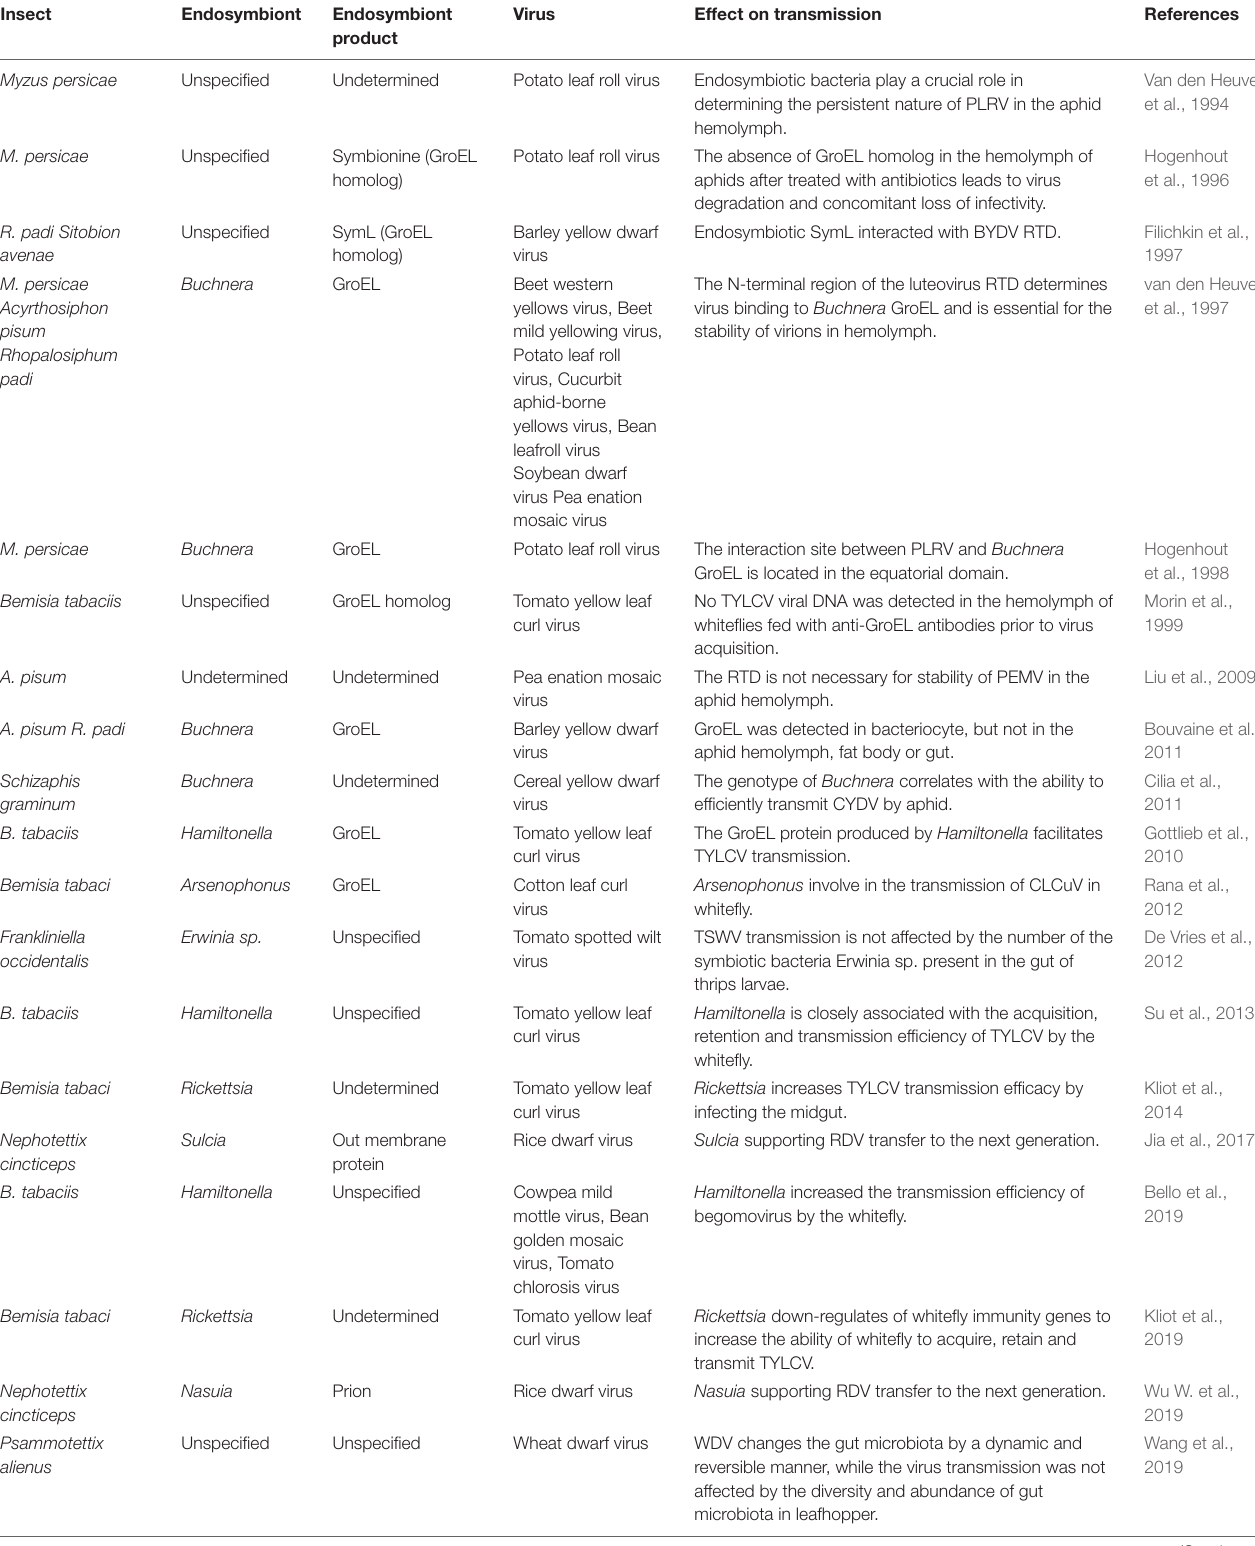
TABLE 1 | Summary of the interactions of insect endosymbionts with plant viruses demonstrated by in vitro or in vivo